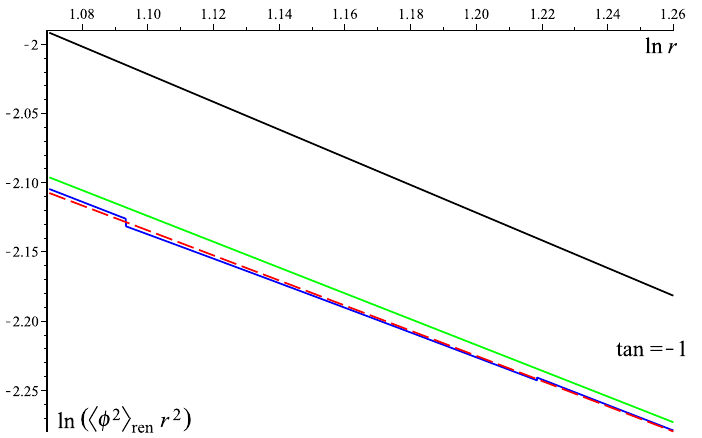
Figure 3. Plots of ln ( r 2 (cid:104) φ 2 (cid:105) ren ) versus ln r for α = 0.1, computed exactly (by Equation(39), red dashed curve), for the main asymptotic term ( k max = 0, by Equation(41), black curve), for k max = 3 (in Equation(40), green) and for the r -truncated series (by Equation(42), blue). The plotting domain corresponds to α r = 0.29...0.35. For higher r , α and more wide range the curves become closer to each other.